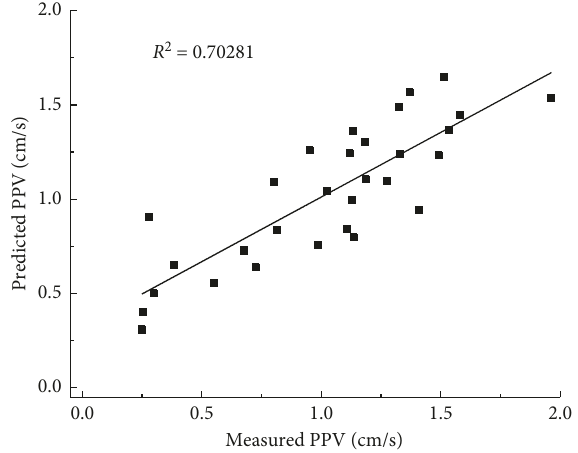
Figure 13: Measured PPVs against predicted PPVs fitted by the Bureau of Indian